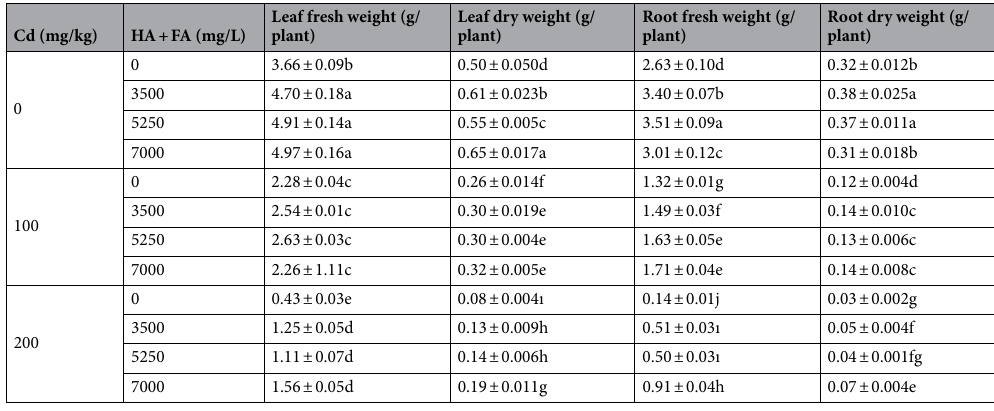
Table 1. Effect of cadmium and HA applications on leaf fresh, leaf dry, root fresh and root dry weight of garden cress. The difference between the means indicated by different letters in the same column is statistically significant (Duncan multiple comparison test, P <